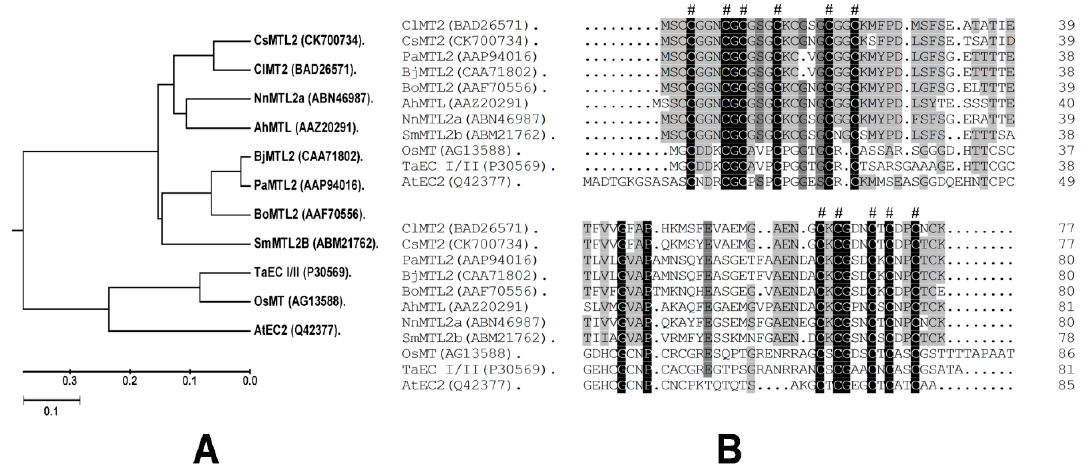
Figure 1. Phylogenetic tree of 11 selected plant metallothionein (MT) proteins and alignment of the deduced amino acid sequence of Cucumis sativus metallothionein-like 2 (CsMTL2) with MT proteins of other plants. ( A ) Phylogenic comparison of the deduced amino acid sequences of plant MT proteins. Scale bar denotes 0.1 amino acid substitutions per site. Accession numbers for the MT proteins used are included with the protein name. The MT genes are from Arabidopsis thaliana (At), Triticum aestivum (Ta), Oryza sativa (Os), Brassica juncea (Bj), Brassica oleracea (Bo), Nelumbo nucifera (Nn), watermelon (Cl), Salix matsudana (Sm), Arachis hypogaea (Ah), Pringlea antiscorbutica (Pa), and Cucumis sativus (Cs). ( B ) Comparison of the deduced amino acid sequence of CsMTL2 with the deduced amino acid sequences of plant MT proteins that have high levels of sequence similarity with CsMTL2. Amino acid residues that are conserved in at least eight of the eleven sequences are shaded, whereas those that are identical in all eleven proteins are in black. The hash symbol represents conserved Cys motifs.